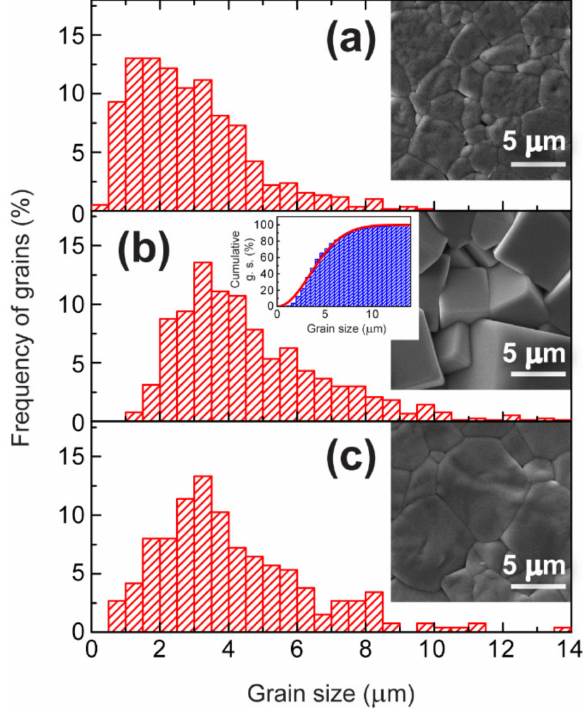
Figure 2. Grain size distributions at various scenarios of thermal treatment: at 980 ◦ C ( a ), at 1240 ◦ C ( b ) and at 980 ◦ C, which followed thermal treatment at 1240 ◦ C (the sample surface layer was grinded off after the first thermal treatment at 1240 ◦ C and the sample was repeatedly polished before the second treatment at 980 ◦ C) ( c ). SEM micrographs of the corresponding surfaces are shown in the insets. The inset in b) also illustrates cumulative grain size distribution together with Rayleigh fit (red